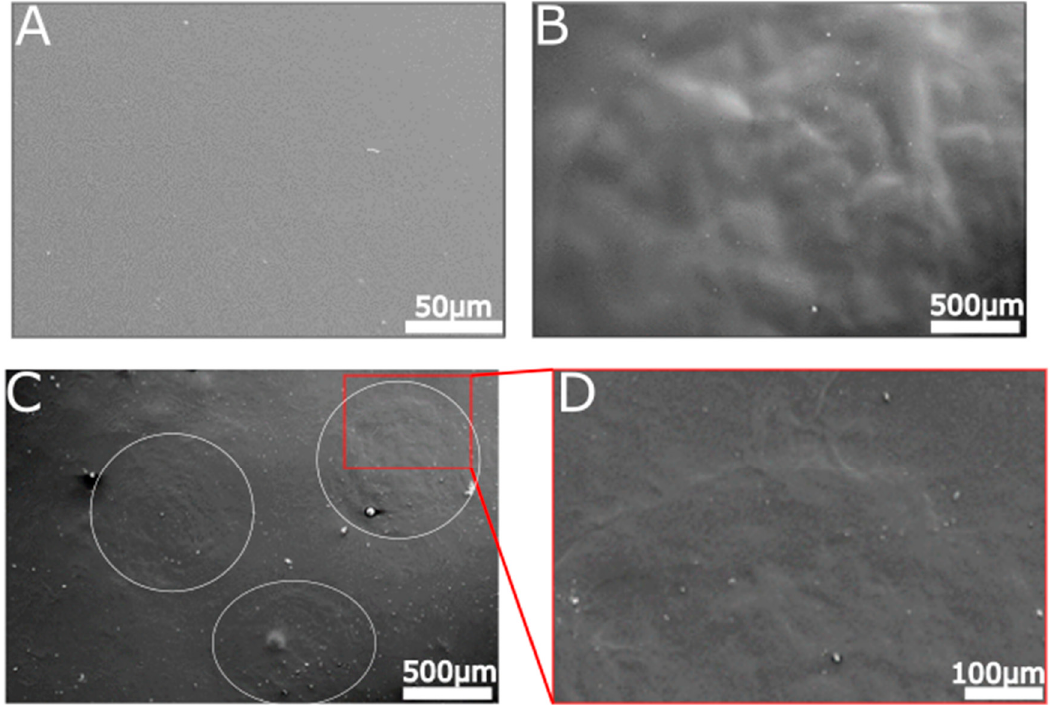
Figure 6. SEM analysis of unhydrolyzed and hydrolyzed CMC films. SEM micrographs of pure CMC film ( A ), CMC film subjected to 10 μ g of cellulase enzyme in a volume of 10 μ L ( B ), and CMC film subjected to nematodes ( C , D ). While the pure CMC film presents a smooth surface, both films subjected to enzyme show a rough pattern. In the film subjected to nematodes, the nematodes location can be seen clearly ( C , marked with white circles). All films were incubated at 37 °C for 2 h with or without enzyme from any source and washed prior to coating for SEM visualization.